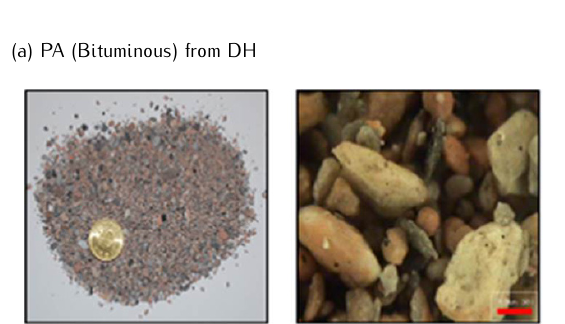
Table 4. Properties of normal